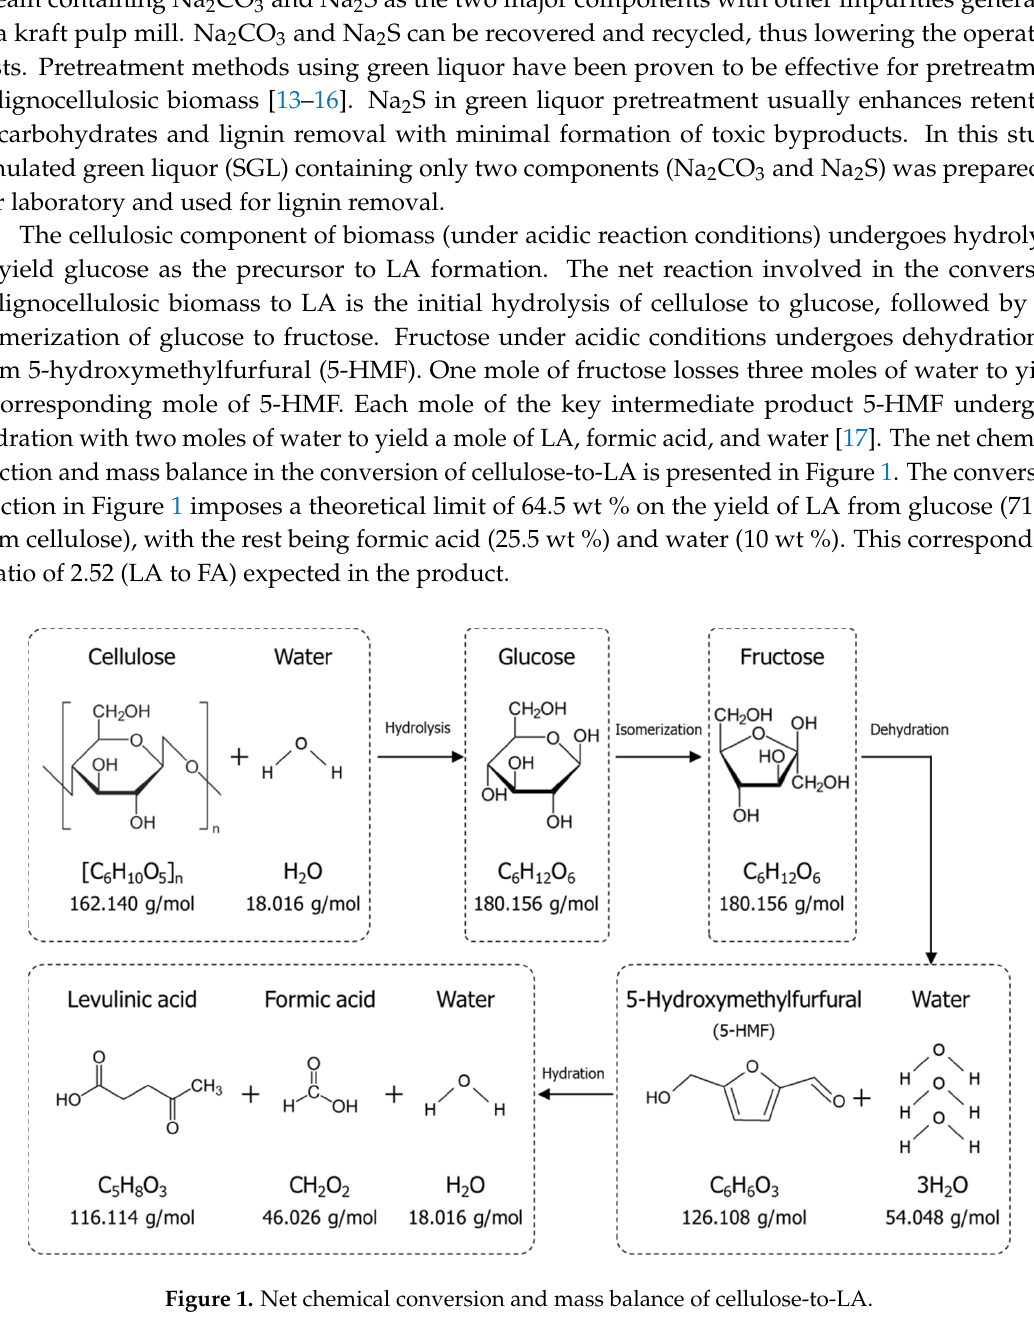
Figure 1. Net chemical conversion and mass balance of cellulose-to-LA.